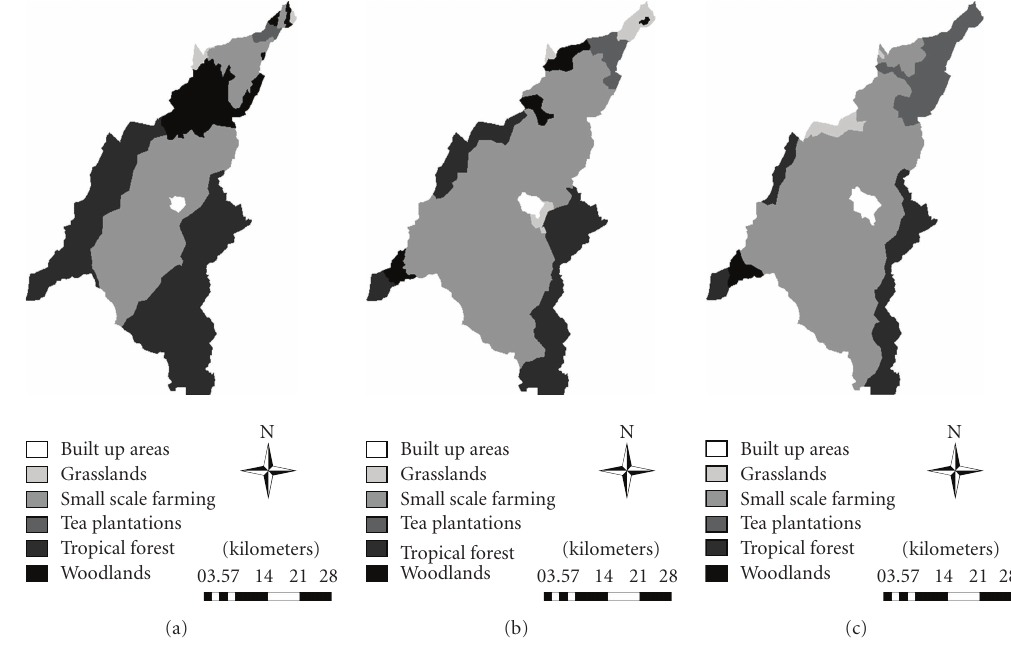
Figure 2: land use/cover for three time series, 1973, 1987, 2009.